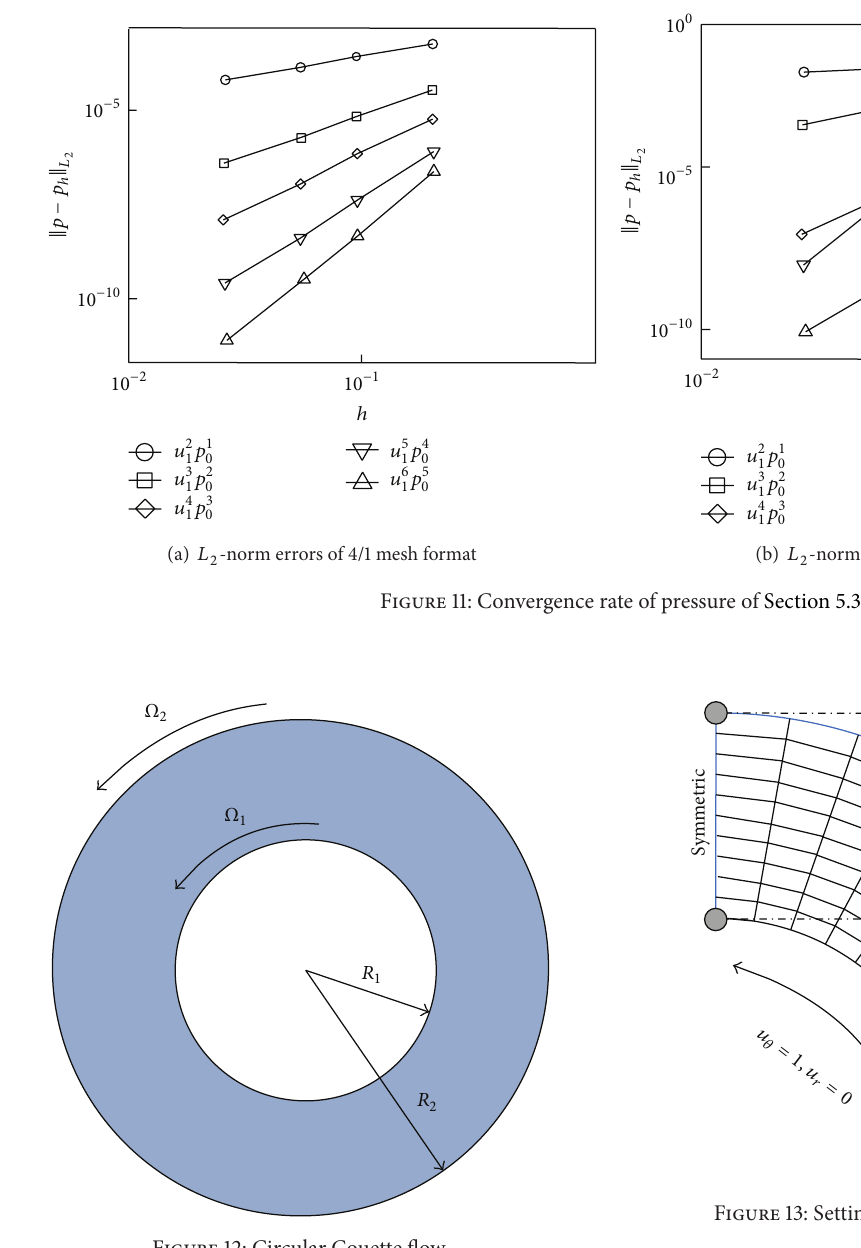
Figure 12: Circular Couette flow.